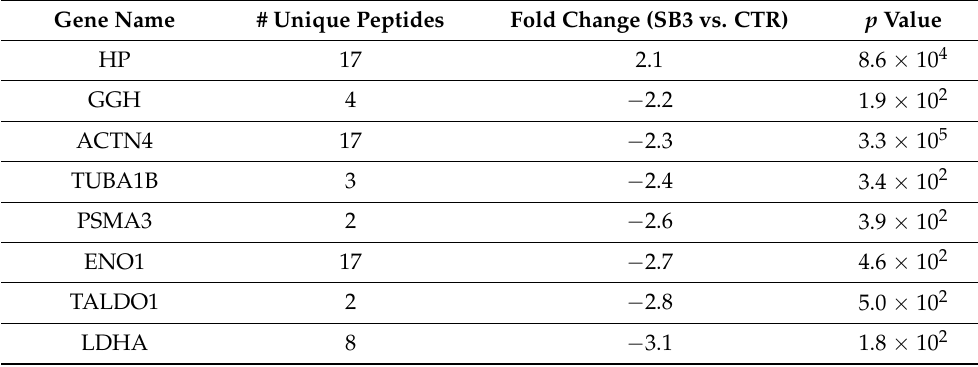
Table 1. Differently abundant proteins detected in nEVs and in EVs-SB3 preparations.